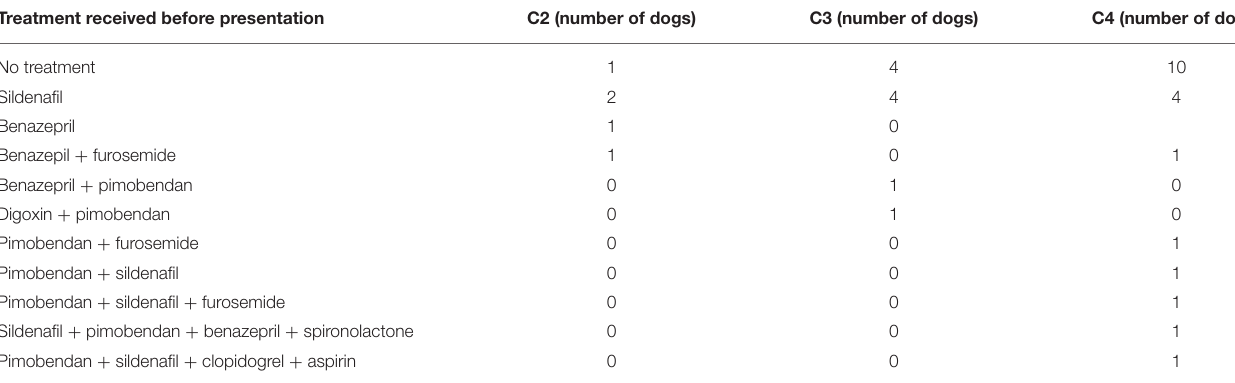
TABLE 3 | Types of treatment received before realization of an